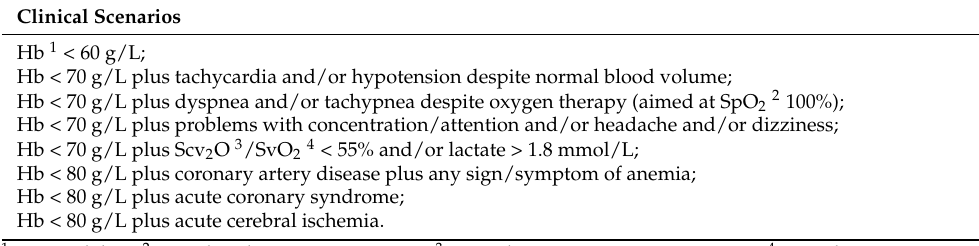
Table 1. Appropriate red blood cell transfusion clinical scenarios. Clinical